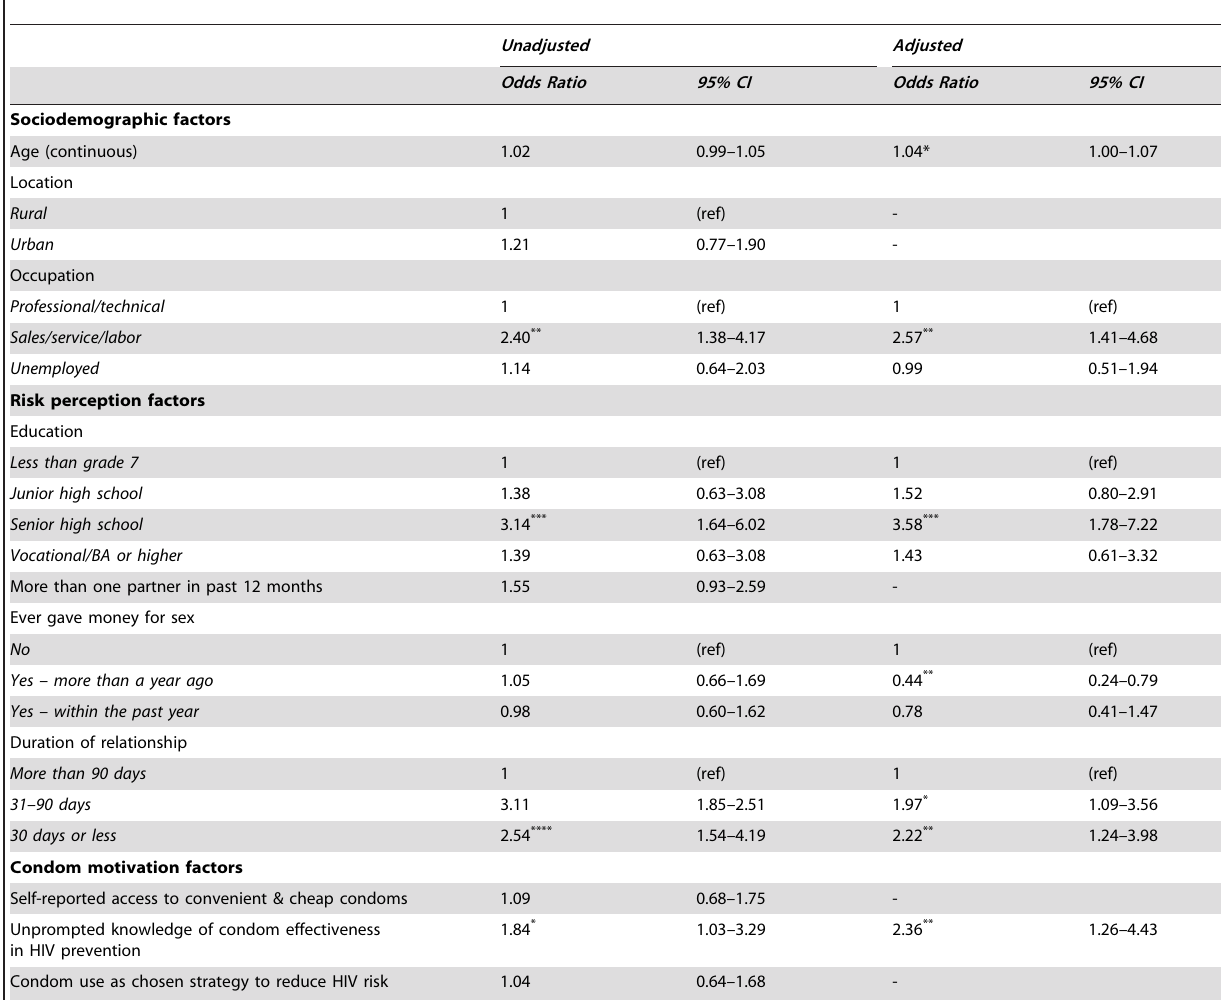
Table 3. Unadjusted and adjusted odds ratios of reporting greater condom use (never, sometimes/half, mostly/always) among men with casual partners